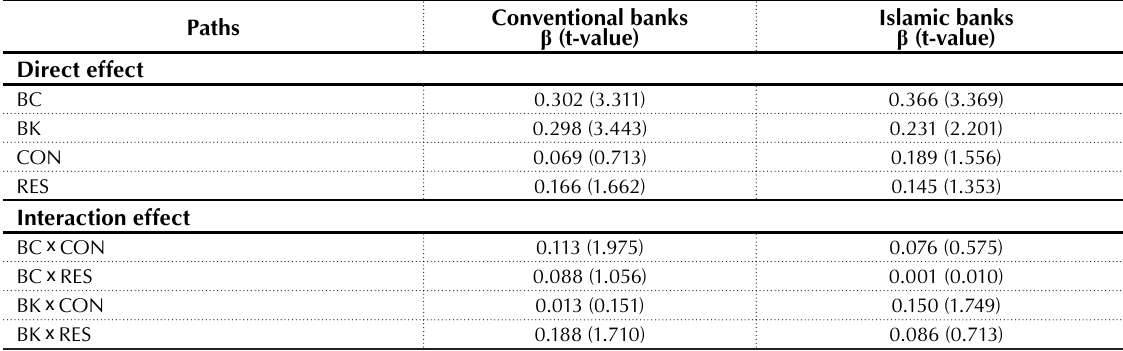
Table 4. Moderation